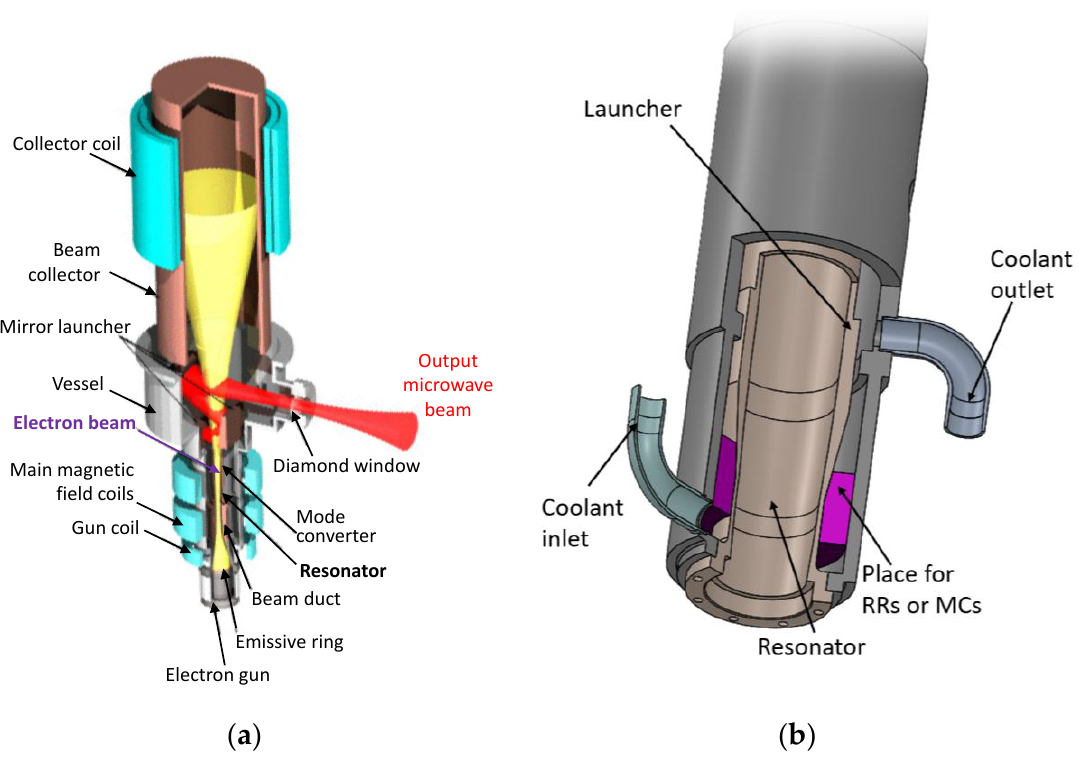
Figure 1. ( a ) Sketch of the cross-section of a gyrotron, with all the components (modified from https://archive.org/details/gyrotron); ( b ) computer-aided design (CAD) view of a section of the gyrotron resonance cavity and launcher.